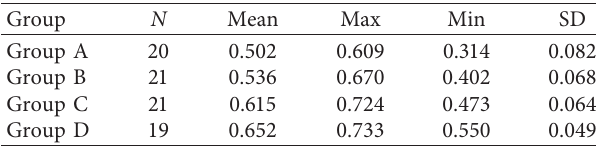
Table 6: Statistical results for different groups’ competence scores.